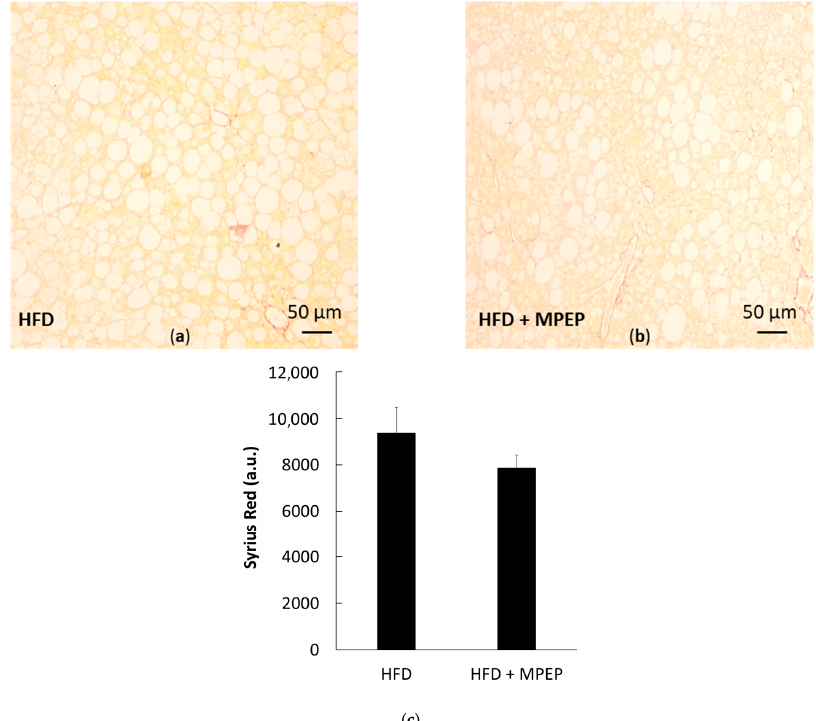
Figure 12. Sirius Red in obese mice. ( a , b ) Sirius red staining in liver sections from obese mice after 7 weeks of HFD administration treated with vehicle ( a ) or MPEP 20 mg/Kg ( b ); ( c ) Quanti fi cation of the Sirius red staining with ImageJ. HFD: high-fat diet + vehicle group; HFD + MPEP: high-fat diet + 20 mg/Kg MPEP group. Results are mean ± SE of 6 individual determinations.